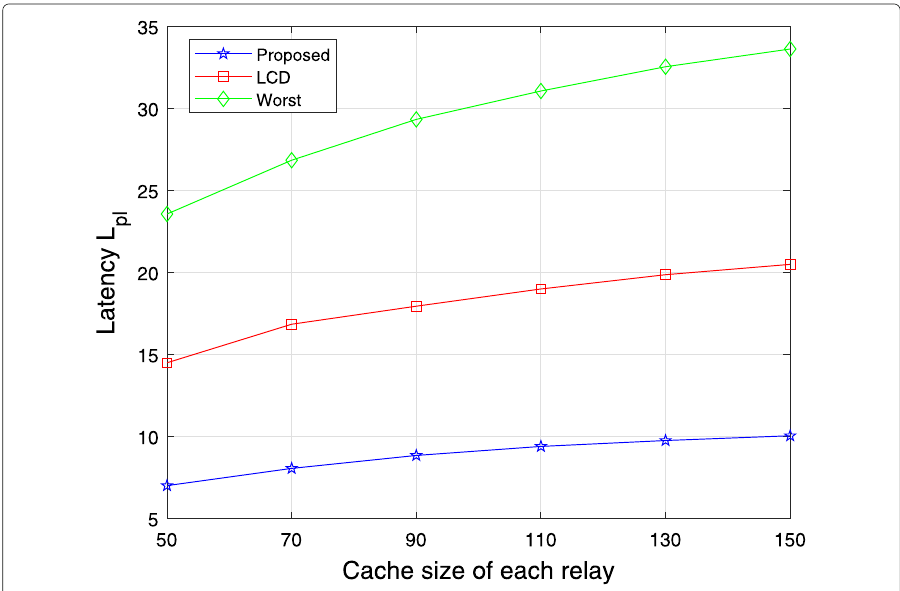
Fig. 11 Latency versus the cache size of each